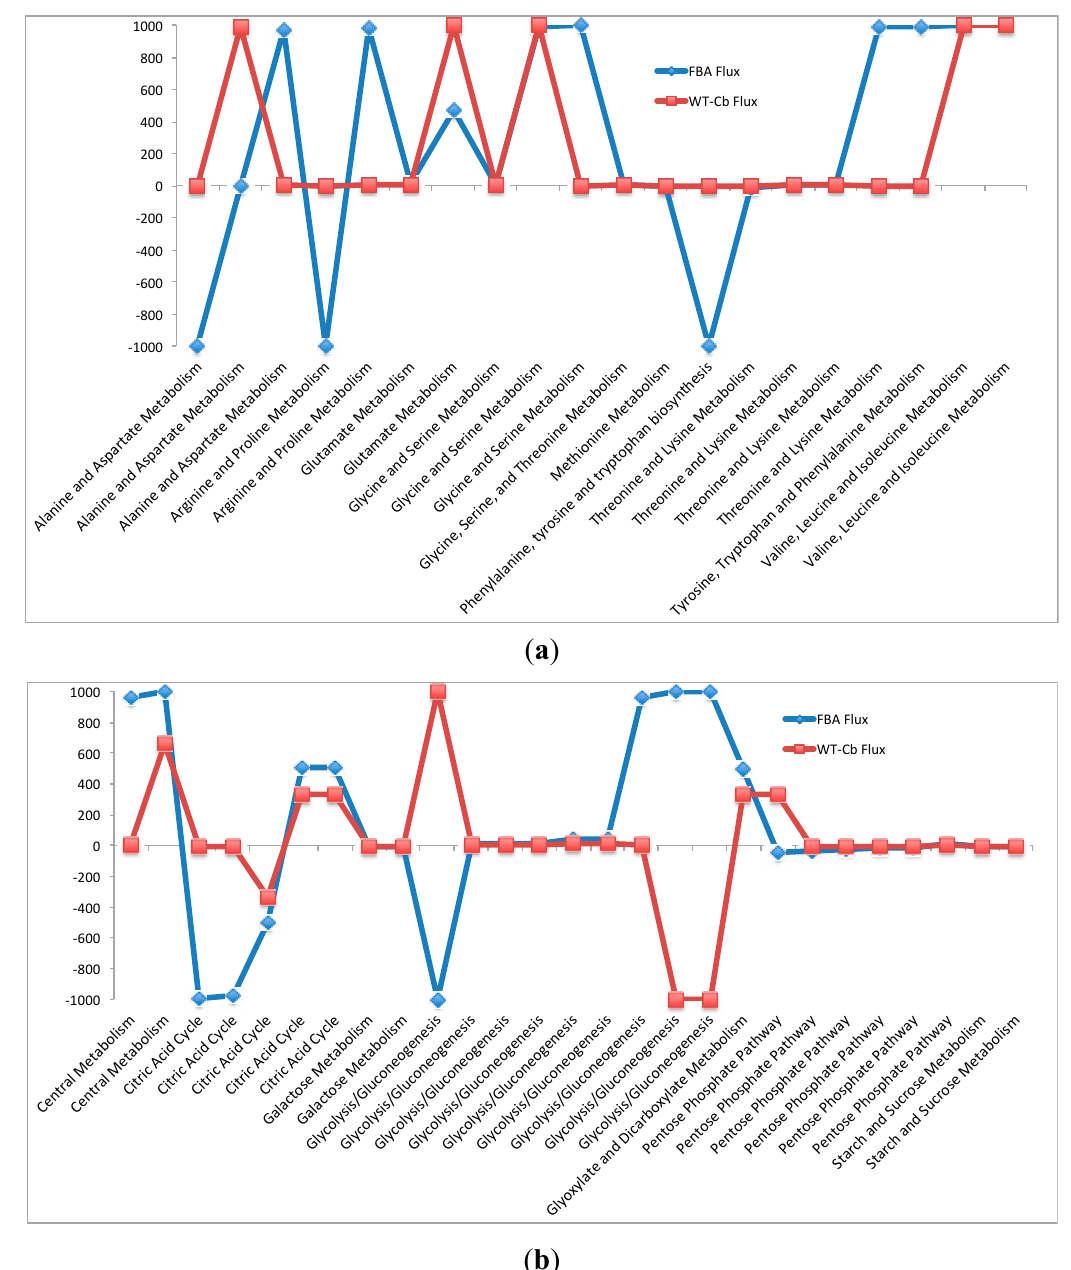
Figure 3. ( a ) Variation in Amino Acid Metabolism—with and without metabolomics data integration. ( b )Variation in Carbohydrate Metabolism—with and without metabolomics data